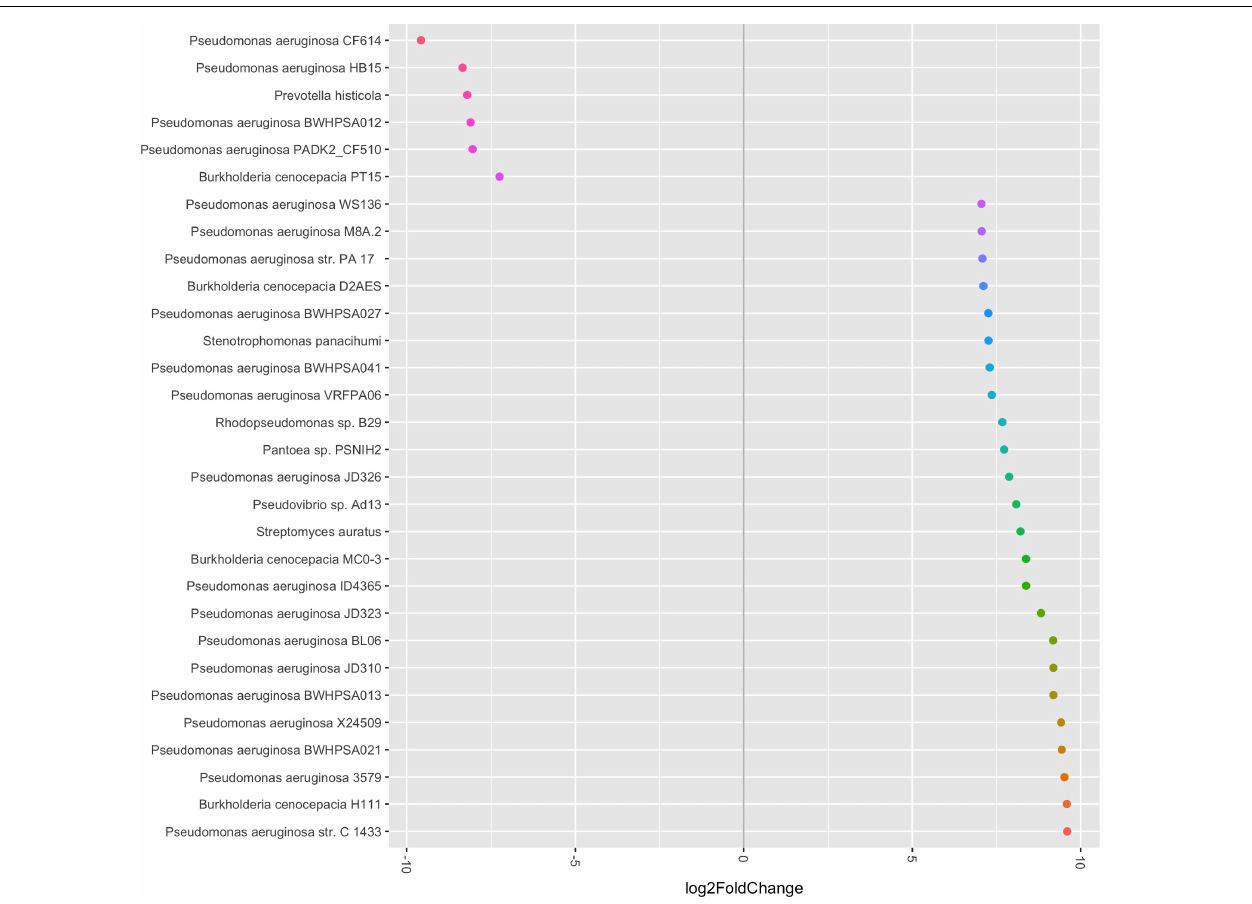
FIGURE 3 | Relative abundance of bacterial species and strains pre- and post-antibiotic treatment. The bacterial species and strains plotted on the left side of the graph were more abundant in the post-antibiotic samples, while the bacterial species and strains plotted on the right side of the graph were more abundant in the pre-antibiotic samples. All fold-changes are significant at p <